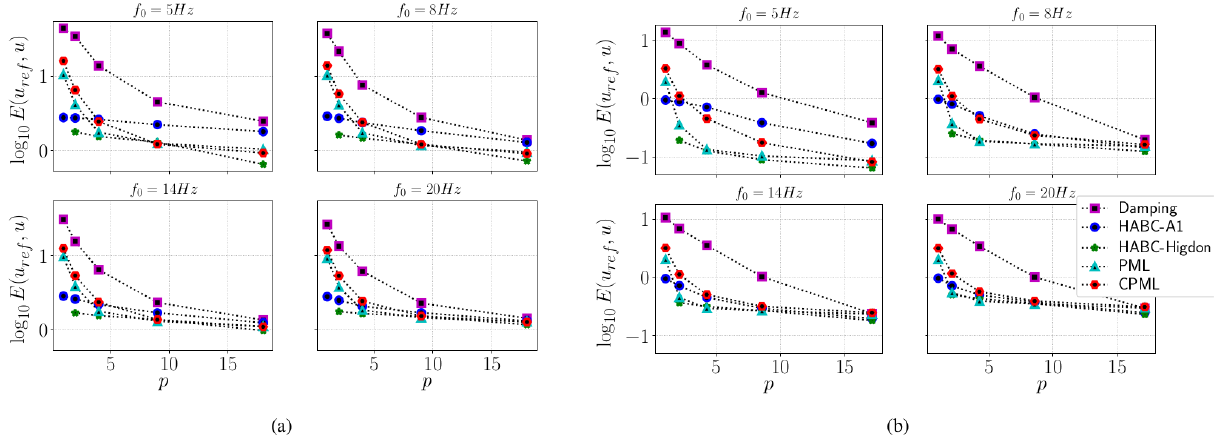
Figure 9. Error curves of the forward solution ( u ) with respect to p (percent of L x ) for different peak of frequency f 0 . The analyses considered the wave solutions for the velocity models, i.e. (a) part of the Marmousi model and (b) 2D SEG/EAGE salt model.